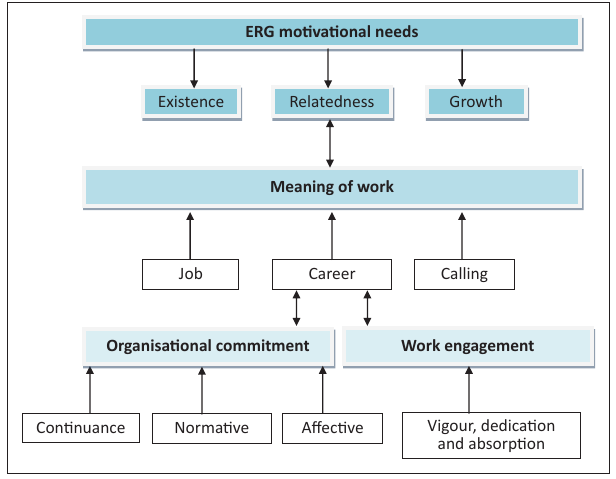
FIGURE 1: The motivation